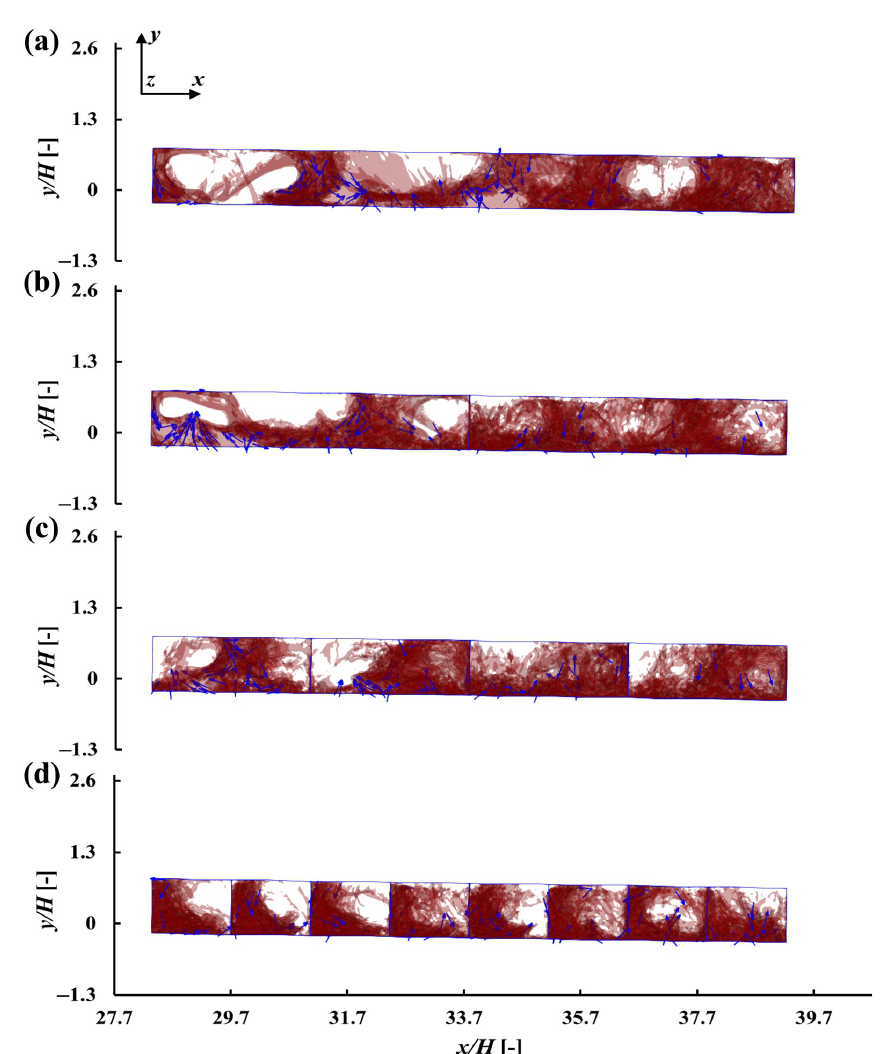
Figure 19. Snapshots for the sloshing tank with D i = 0.5 at t / T = 5.0 for ( a ) N c = 1, ( b ) N c = 2, ( c ) N c = 4 and ( d ) N c = 8. Water phase is shown as transparent red with dark red representing the free surface. Blue arrows show the general direction of motion of the sloshing